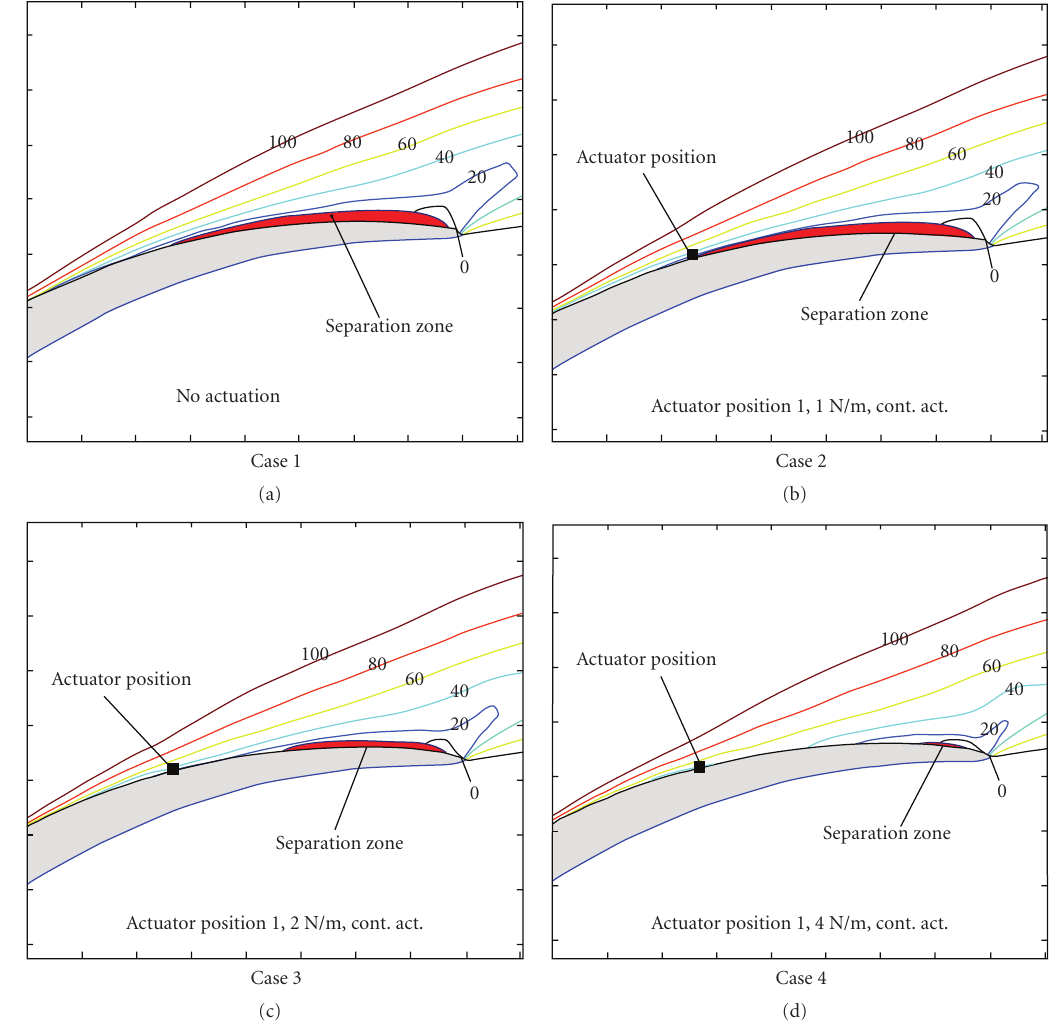
Figure 12: E ff ect of actuator strength on the separated region for cases 1 to